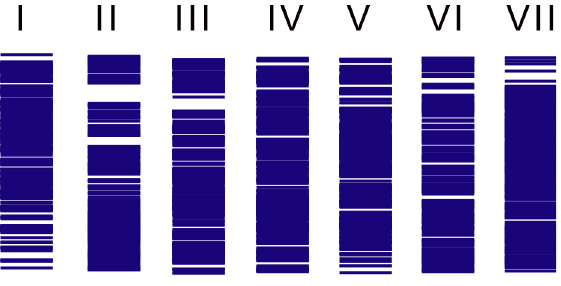
Fig 3. Markerdistribution across the artificial LGs presentedin